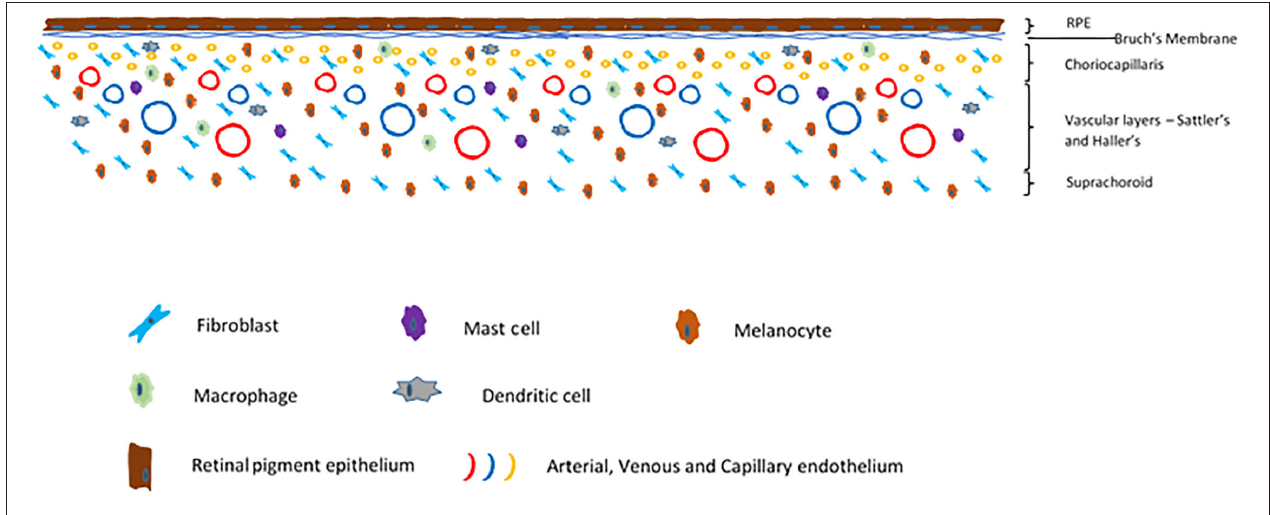
FIGURE 4 | Schematic of a cross section of the